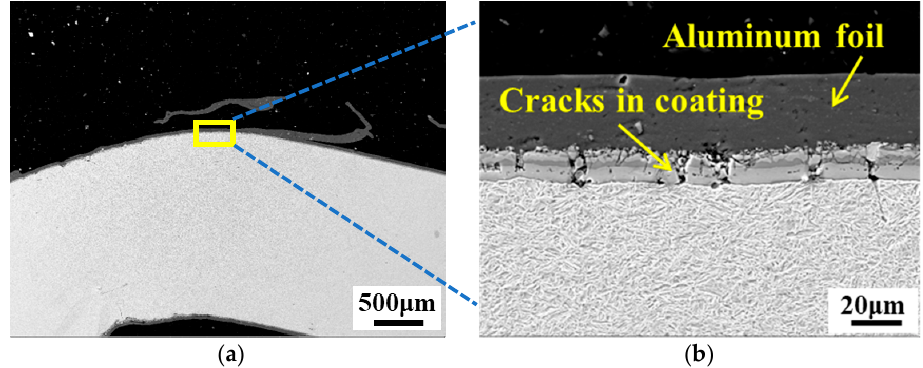
Figure 2. ( a ) SEM micrograph of the cross ‐ section of a bent PHS specimen after heat treatment; ( b ) cracks in the Al–Si coating (the enlargement of the yellow rectangle in ( a )).